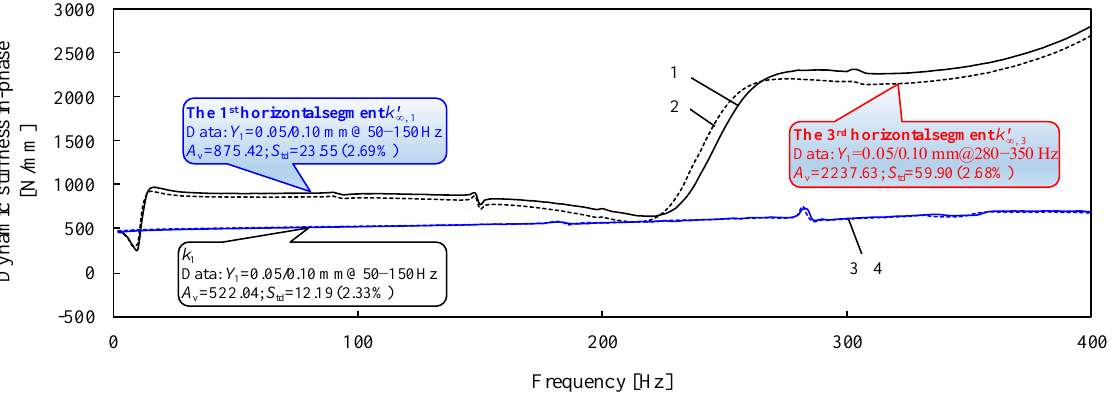
Figure 6. Experimental validation of active FRFs in the fluid-filled state . Key : Measured FRF | F 1 / I | (—); measured FRF | F 5 / I | (- -).